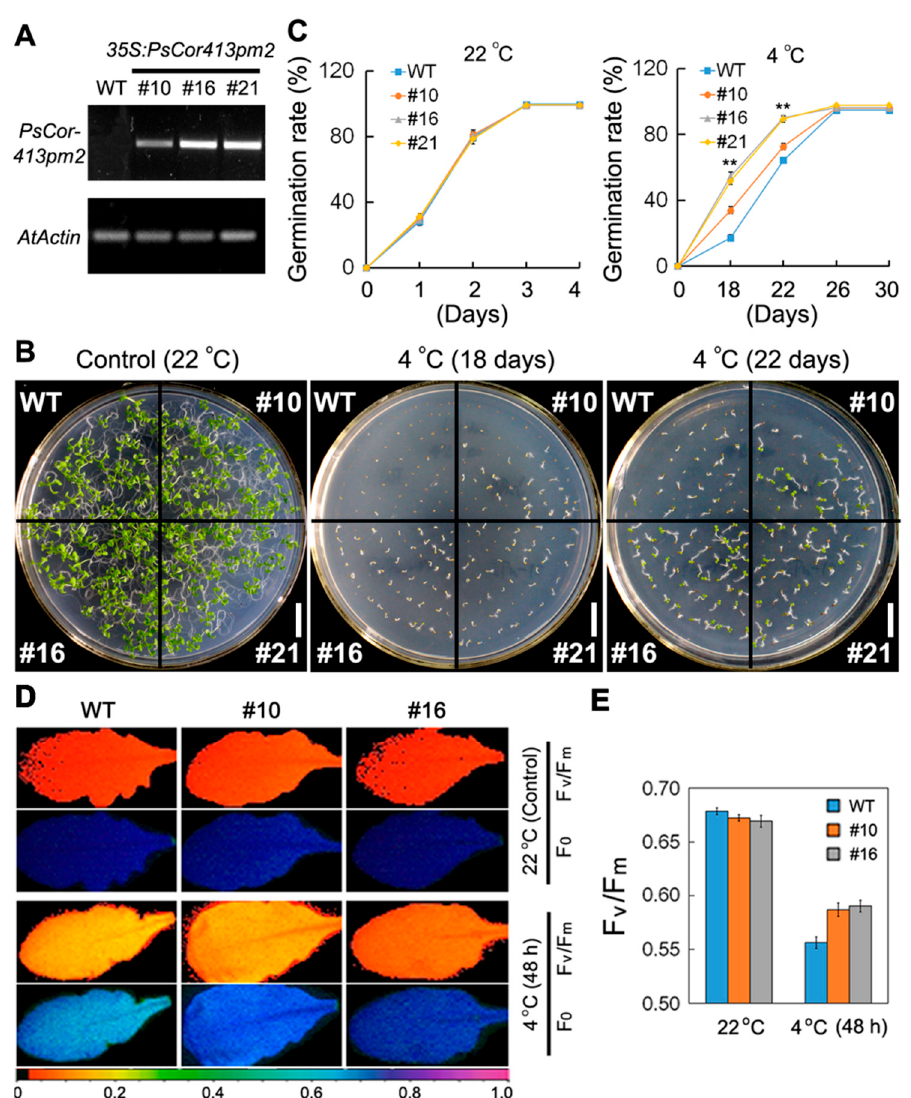
Figure 4. Phenotypes of transgenic Arabidopsis and wild type (WT) seedlings under low temperature stress. ( A ) Semi-quantitative PCR analyses of PsCor413pm2 expression in WT and three transgenic Arabidopsis lines (#10, #16, and #21) overexpressing PsCor413pm2 . ( B , C ) Comparison of germination rates in the WT and three transgenic lines on 1/2 strength Murashige and Skoog (MS) medium under normal (22 ◦ C) and cold (4 ◦ C) stress. Maximal photochemical efficiency (Fv/Fm) of transgenic Arabidopsis and WT leaves under cold stress. F 0 and Fv/Fm images ( D ) and their quantification analysis ( E ) of leaves of WT and transgenic lines (#10 and #16) under normal (22 ◦ C) and cold (4 ◦ C, 48 h) stress. The pseudocolored bar depicted at the bottom of the panel ranges from 0 (black) to 1.0 (purple). Asterisks indicate significant differences between WT and transgenic lines (** p < 0.01; Student’s t test). Error bars show standard error (SE) of the values from three replicates. Scale bars = 1 cm.